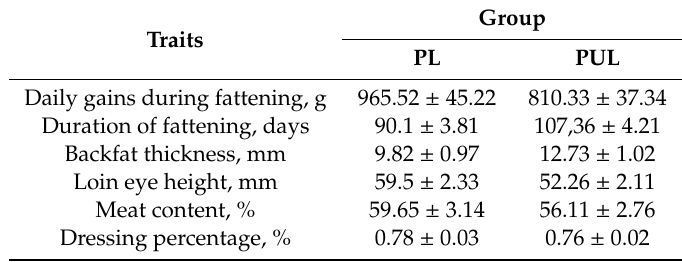
Table 1. Fattening results and slaughter value parameters of experimental pigs (mean ±